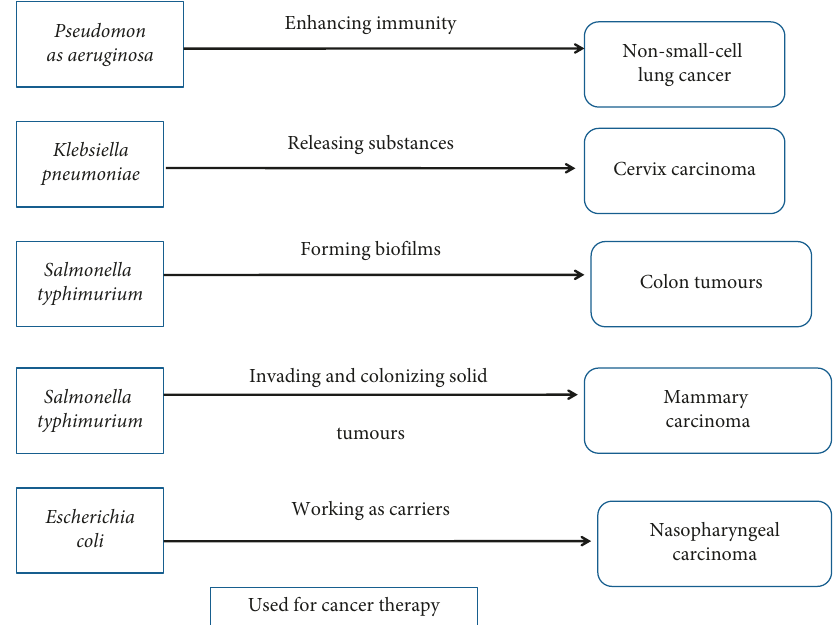
Figure 2: Bacteria involved in treating different types of